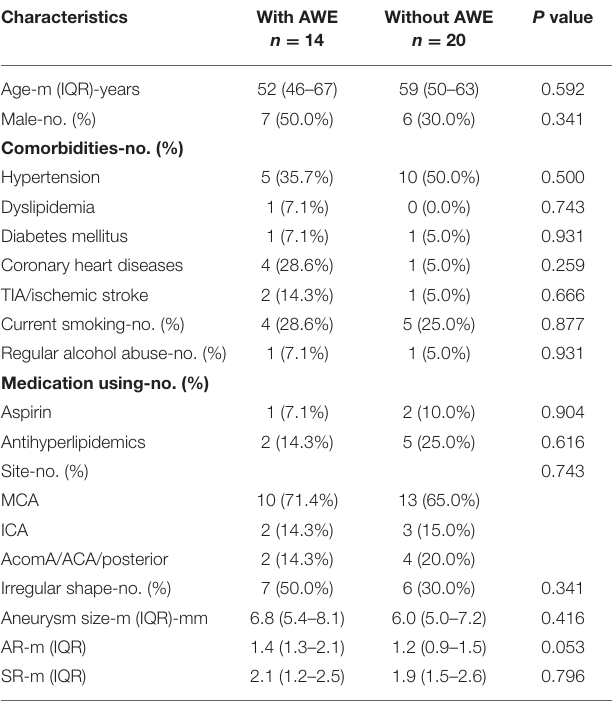
TABLE 1 | The clinical and radiological information of patients and UIAs.